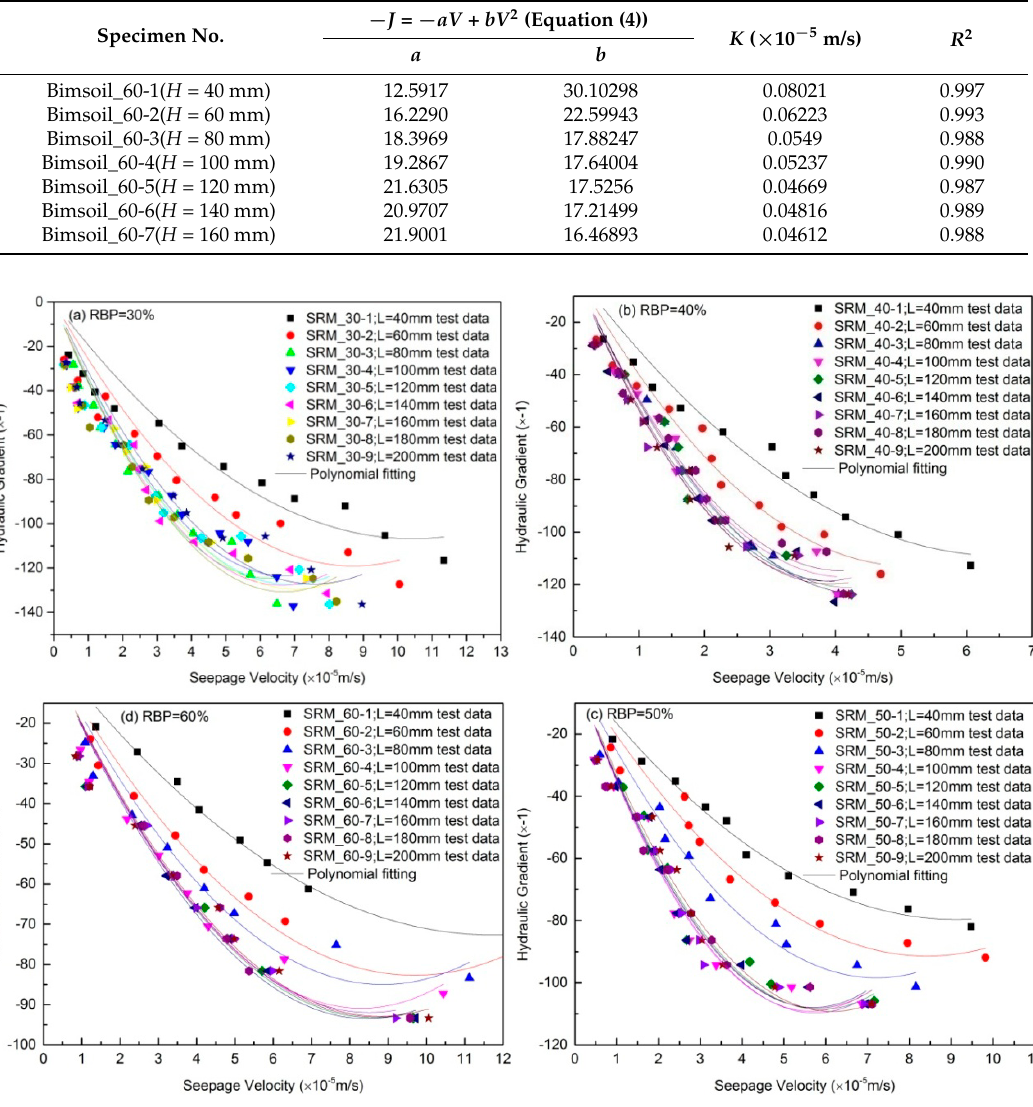
Figure 9. The curves of negative hydraulic gradient and seepage velocity for samples with height from 40 m to 200 mm: ( a – d ) the RBP is 30%, 40%, 50%, and 60%,